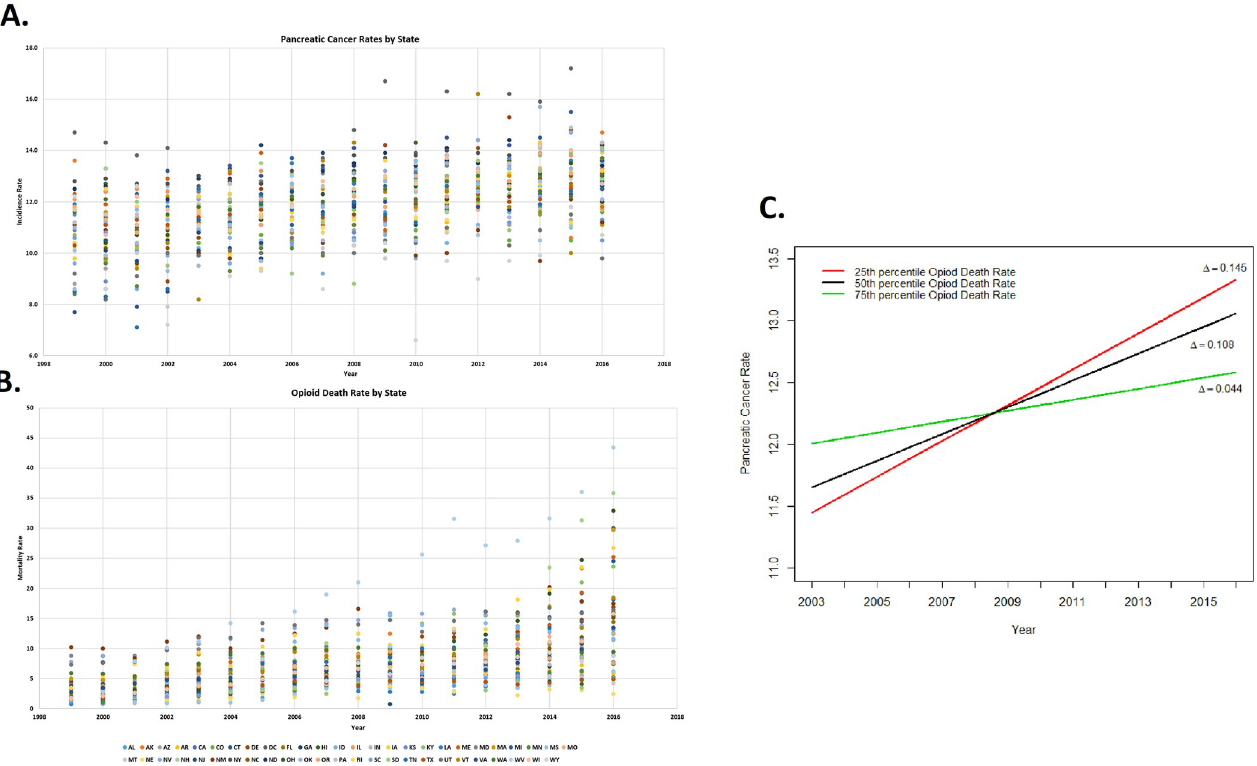
Fig 2. (A) Incidence rate of pancreatic cancer over time per 100,000 people, State incidence rate of pancreatic cancer through the years 1999 to 2016, (B) Incidence rate of opioid death overtime per 100,000 people, State incidence rate of opioid death through the years 1999 to 2016, (C) A state with an opioid death rate in the 25 th percentile in 1999 had an annual increase in PC that was 34 percent faster than a state at the median opioid death rate and 3.3 times faster than a state with an opioid death rate in the 75 th percentile.